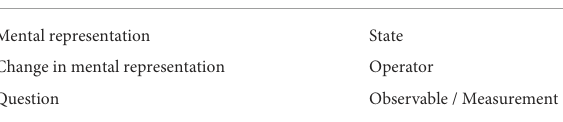
TABLE 2 Correspondences between psychological constructs, and terms from the quantum